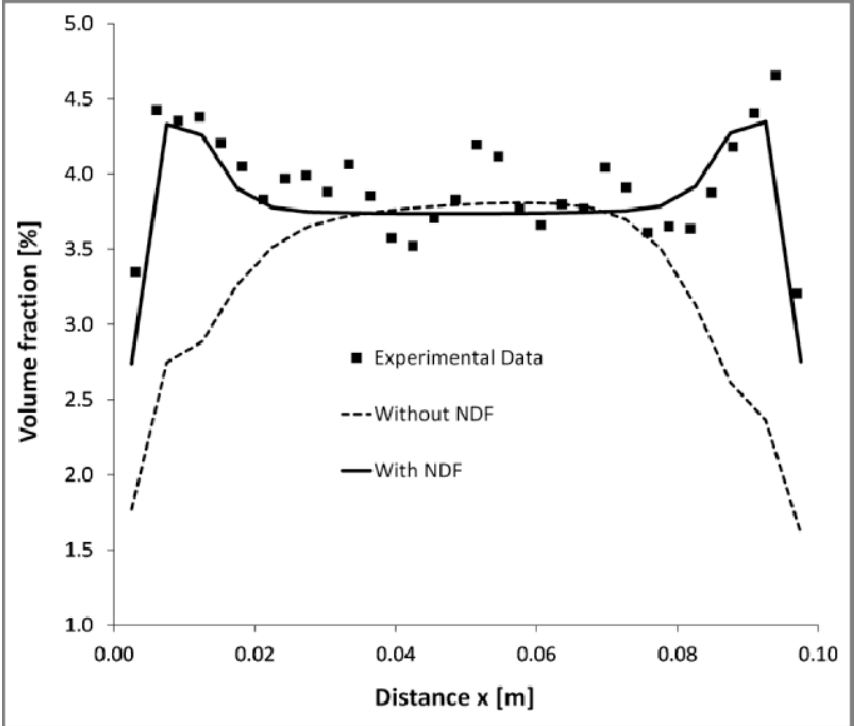
Figure 10. Influence of Non-Drag-Forces (NDF), (with the exception of the virtual mass force) on the local void fraction profile. Reprinted with permission from